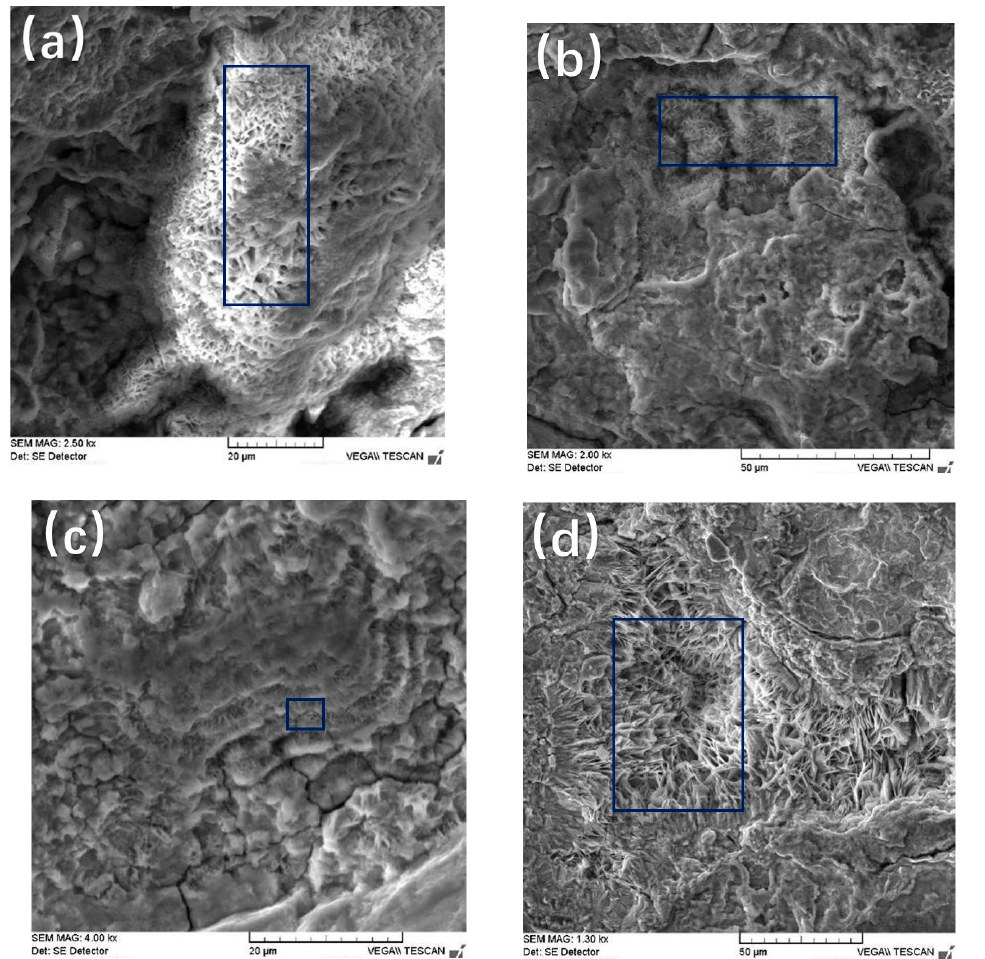
Figure 8. Morphology of inclusions at crack source. ( a ) zone 1; ( b ) zone 2; ( c ) zone 3; ( d ) zone 4.